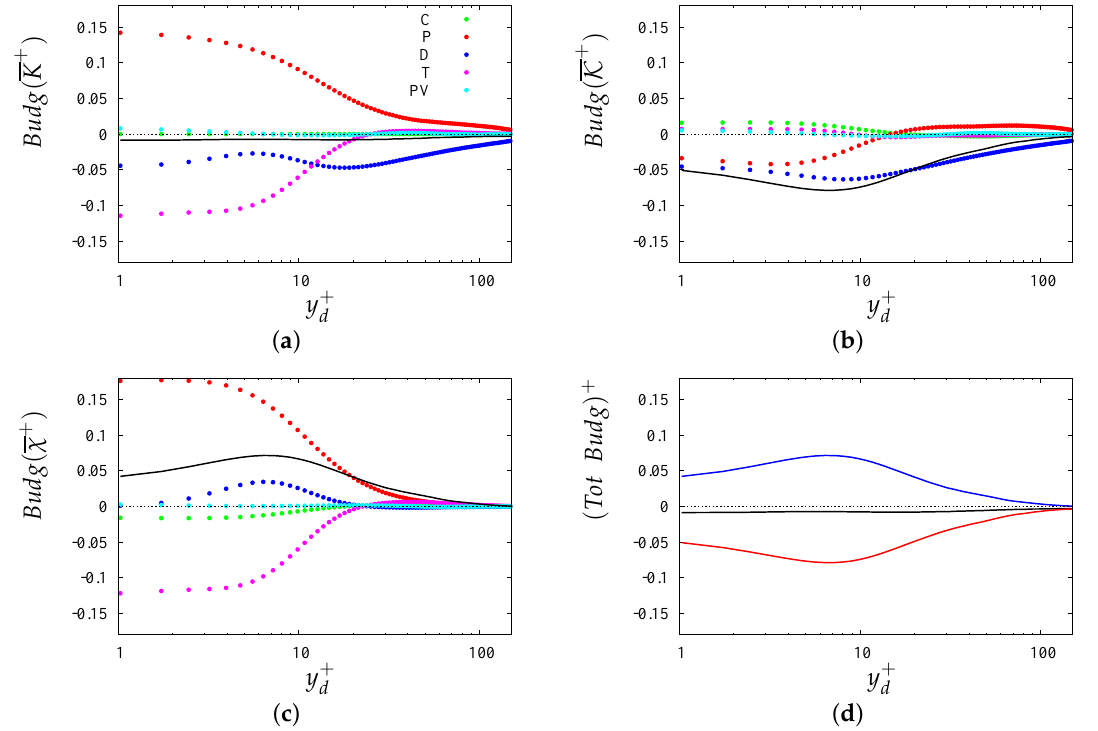
Figure 10. Inner-scaled profiles of terms in the turbulence kinetic energy budget for SLL corrugations: ( a ) total, ( b ) inco- herent part (solid symbols), ( c ) coherent part; ( d ) sum of all terms (the blue line is the sum of terms in ( c )), and the red is the sum of terms in ( b )). The legend of symbols is provided the inset of panel ( a